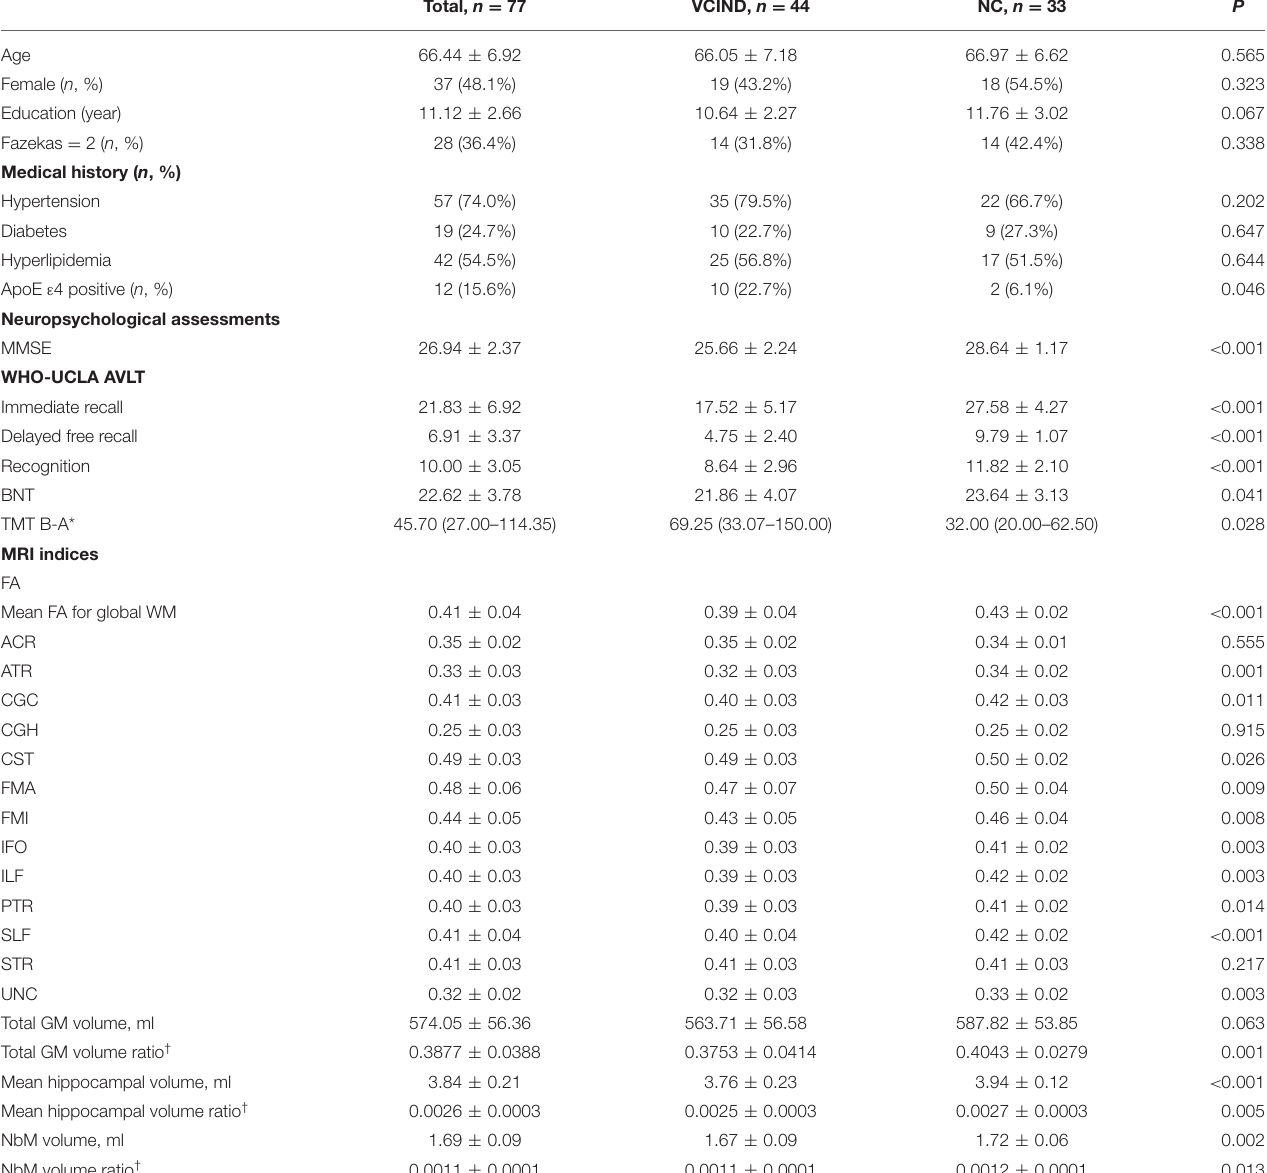
TABLE 1 | The characteristic, neuropsychological assessments and MRI results of the